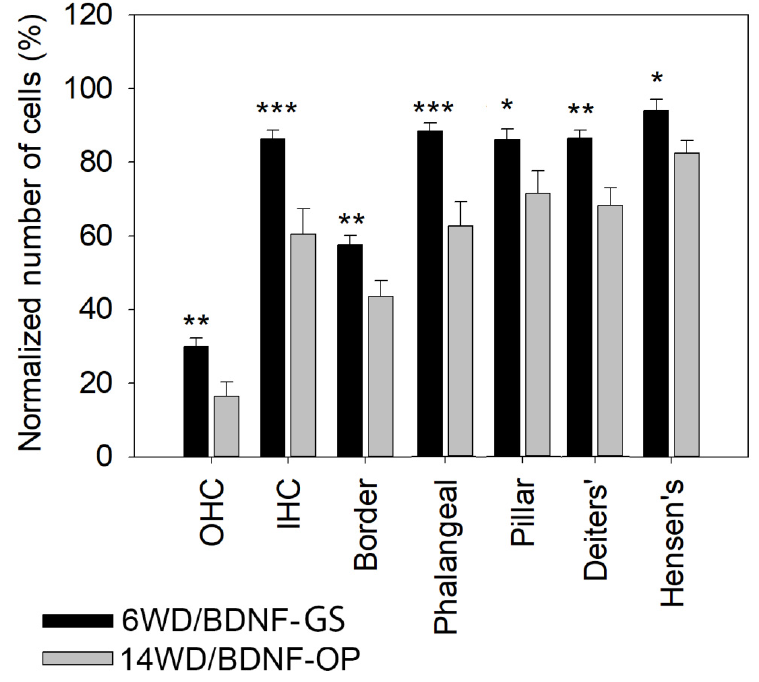
Figure 9. Comparison of HCs and SCs cell numbers between cochleas of six and 14 weeks deaf animals. Treated and untreated cochleas for each time point were merged (6WD/BDNF-GS and 14WD/BDNF-OP). Graphs are shown as mean ± SEM (6WD/BDNF-GS: n = 22; 14WD/BDNF-OP: n = 13) and show total cell count of each cell type over all cochlear locations. Number of cells is normalized as % of NH (100%). Statistical analysis was performed through Mann Whitney test; * p < 0.05, ** p < 0.01, *** p < 0.001. 3.3. Correlation between Spiral Ganglion Cell Density and Supporting Cell Number SCs are gaining increasing interest as important mediators of cell survival of neighboring cells and downstream SGCs [3]. On this basis, we wondered whether a cor- relation between SGC survival and the number of remaining SCs existed in our experi- mental conditions. Specifically, we correlated the SGC packing density with the total number of SCs, considering the total amount derived from the sum of all the SC types (Figure 10). The BDNF-GS cochleas showed a significantly increased SGC packing den- sity in the basal turns compared to the untreated cochleas ( p < 0.001) (Figure 10A), as previously reported [15]. Conversely, the SGC packing density was similar between treated and untreated ears in the middle and apical turns (Figure 10A). However, this data was not associated with any differences in the total SC number, which instead was similar in treated and untreated ears over all cochlear locations (Figure 10A). The BDNF-OP group showed a different scenario, with a significantly increased SGC packing density in the basal, middle, and apical turns compared to the untreated group (Base: p < 0.01, Middle and Apex: p < 0.001) (Figure 10B). However, as also observed in the BDNF-GS study, no correlation was found between the SGC survival and the number of SCs. Indeed, the total number of SCs was similar for BDNF-OP and vehicle-injected ears in the basal, middle and apical turns (Figure 10B). Likewise, SGC packing density plotted against the total number of SCs of individual cochleas of both the BDNF studies showed no correlation between the two variables (R 2 = 0.077, p = 0.119) (Figure 10C). We also investigated whether any association existed be- tween SGC packing density and the number of specific subtypes of SCs over all cochlear locations. No statistically significant correlation was found ( p > 0.13) (data not shown).